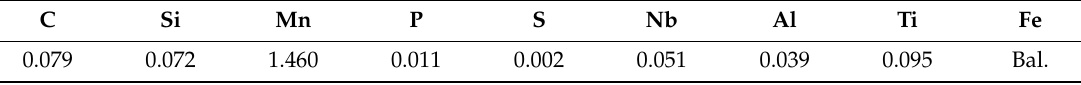
Table 1. Chemical composition of 700 L steel (wt